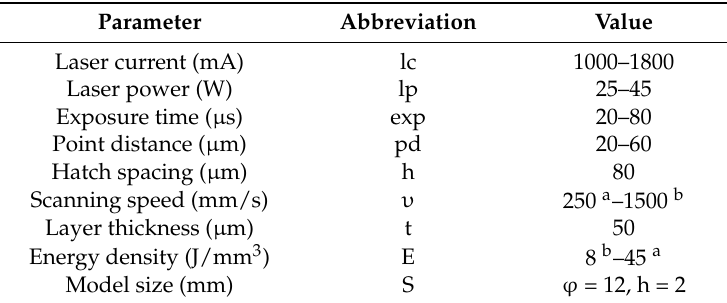
Table 1. The process parameters used for samples